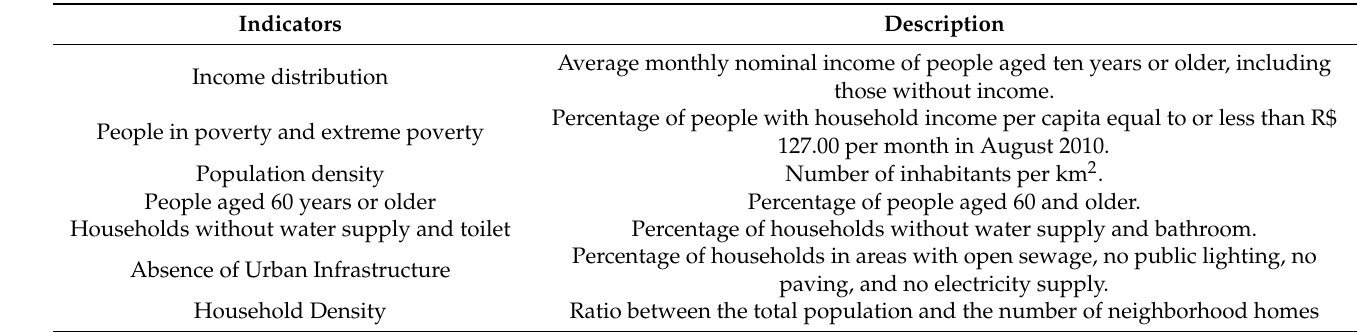
Table 1. Indicators that integrate the Potential Epidemic Vulnerability